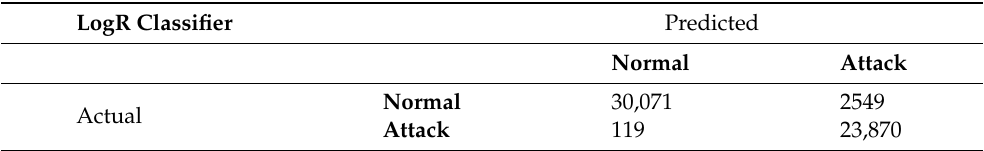
Table 7. Confusion matrix of Logistic Regression (LogR) Classifier test for malicious and normal traffic detection over IoT healthcare dataset generated using IoT-Flock [16,24].